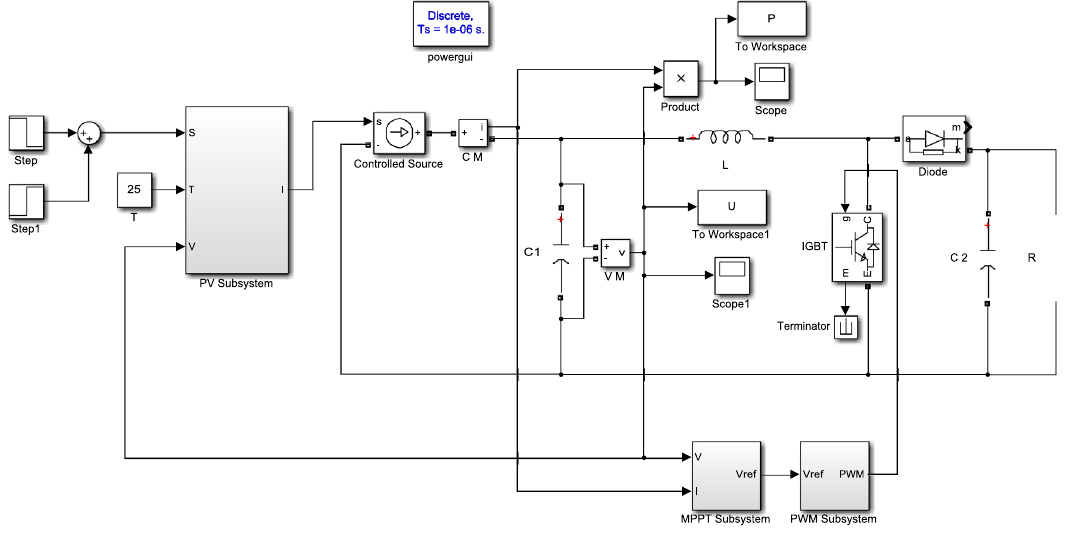
Figure 10. System simulation model.